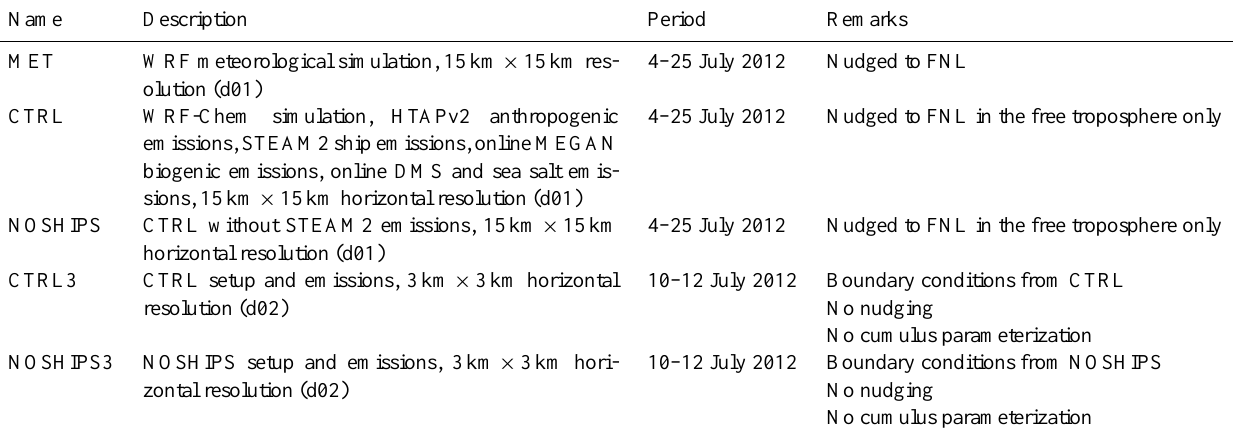
Table 3. Description of WRF and WRF-Chem